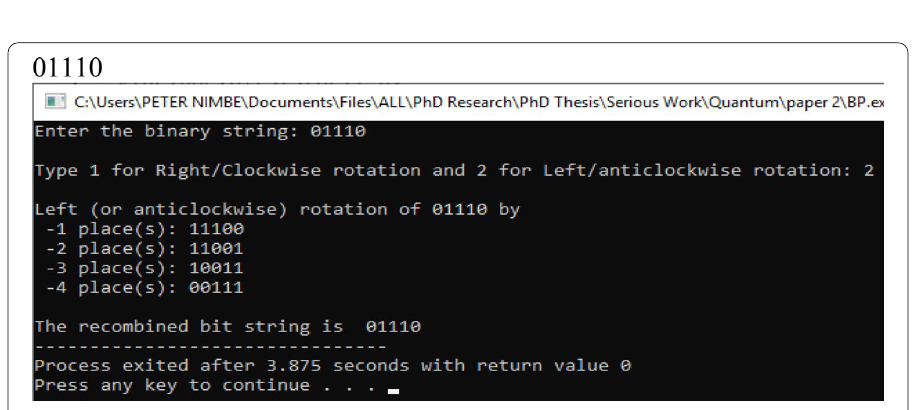
Fig. 15 Left or anticlockwise rotation of